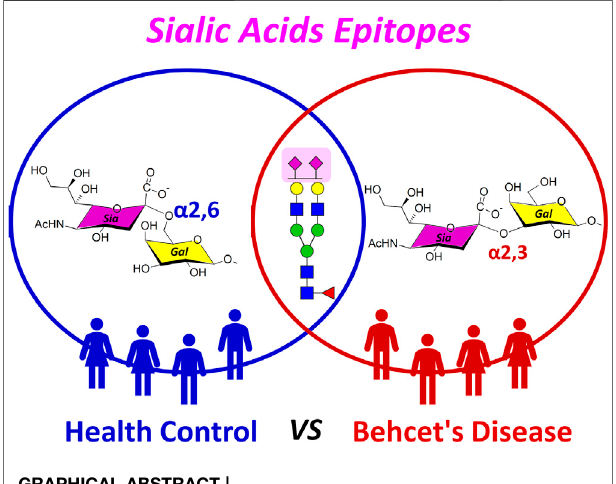
identi fi ed in all clinical samples. We con fi rmed that three